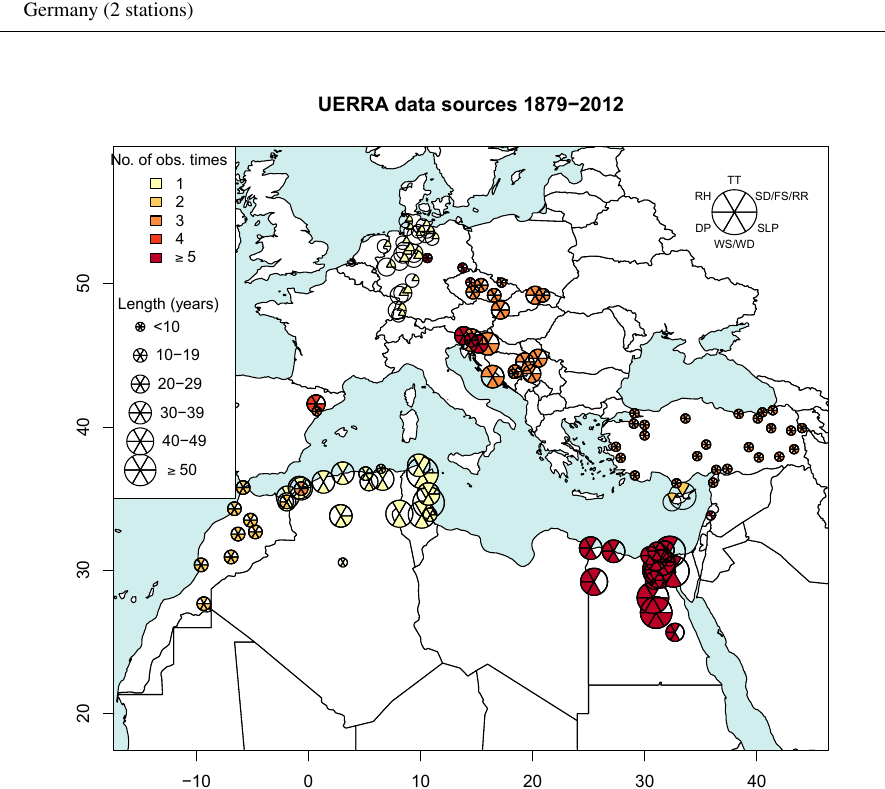
Figure 7. Spatial coverage of 8.8 million observations digitised, showing the station locations. The approximate length of the record at each station is indicated by the size of the pie symbol; the number of observations per day is represented by the colour of the pie pieces; and the different variables available at each station are indicated by which wedges are shaded based on the legend in the top right corner. Variable acronyms are as those described in the caption to Table 1, apart from SLP, which represents station and sea level